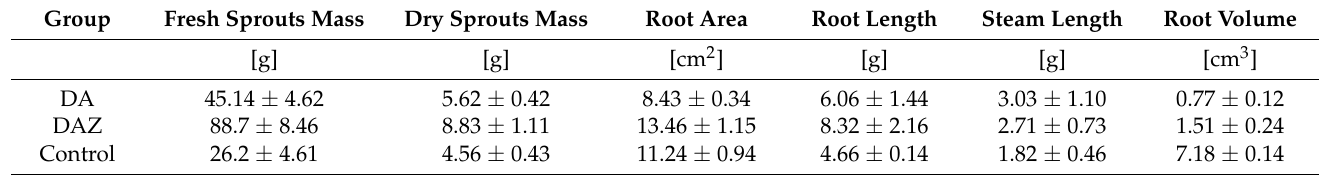
Table 6. Biomass and roots